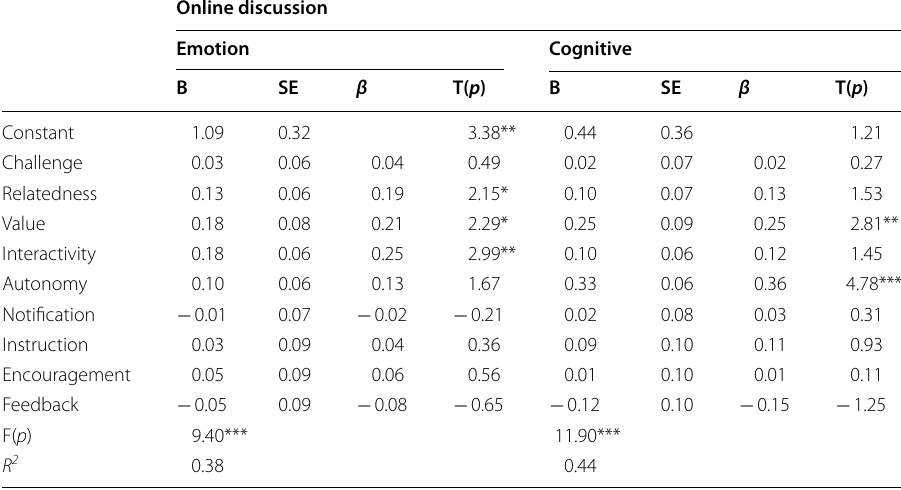
Table 6 Result 2 of Multiple linear regression analysis (n